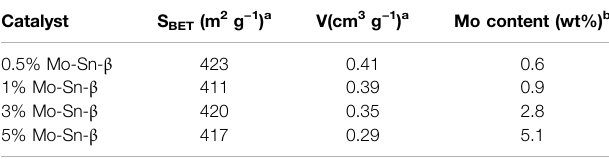
TABLE 1 | Physicochemical properties of Mo-modi fi ed Sn- β . Catalyst